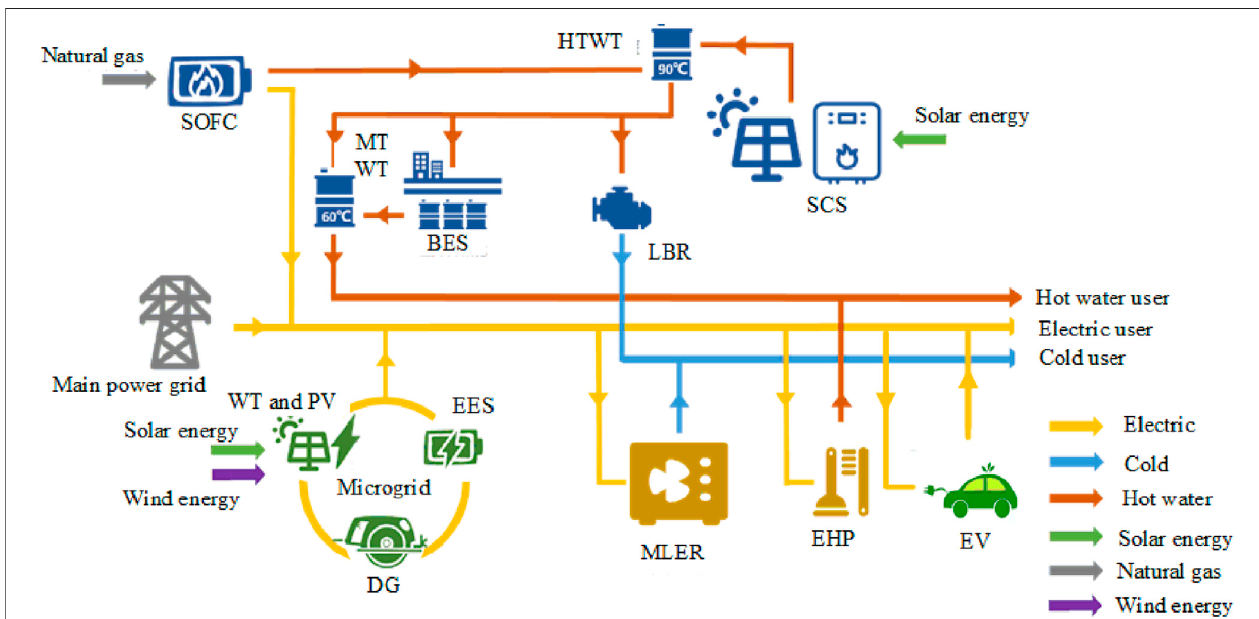
FIGURE 1 | Schematic diagram of the multi-energy integrated